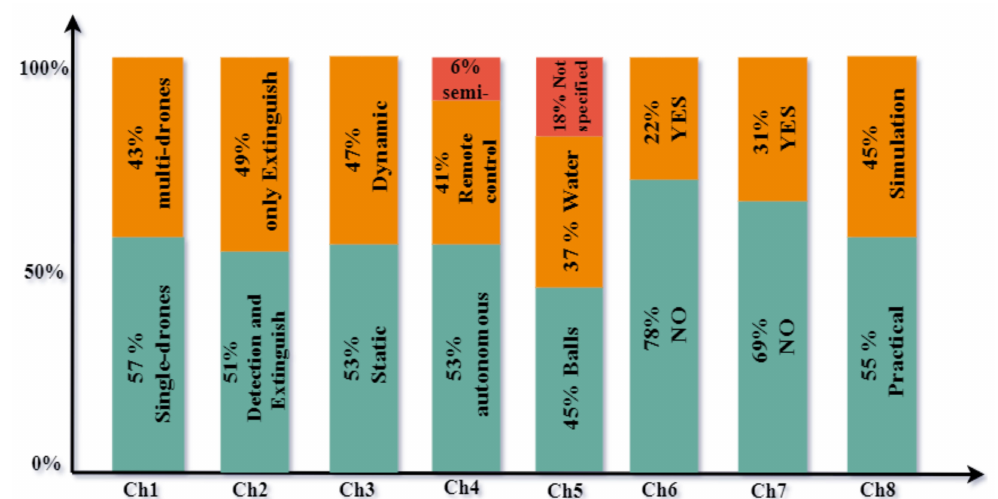
Figure 7. The number of papers per characteristic of the fire-extinguishing